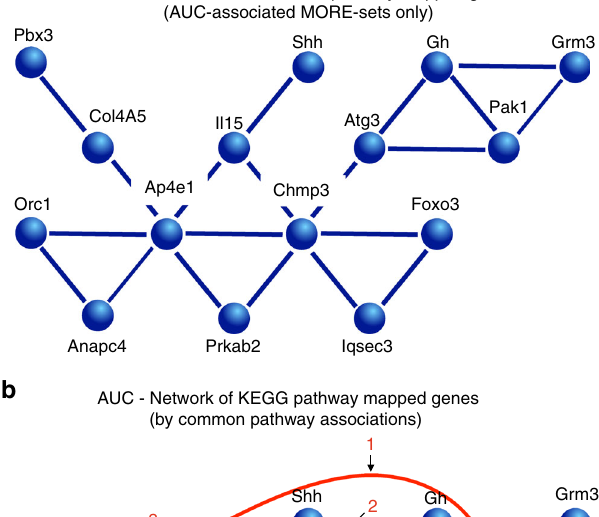
Fig. 6 The joint MORE set and KEGG pathway network. Fifteen genes from the gene list AUC female impaired (KEGG) for which MORE set connections were also found. Male impaired did not yield results. a AUC gene network derived from KEGG pathway-mapped genes showing AUC- associated MORE sets only. b AUC gene network of KEGG pathway- mapped strong knockout genes by common pathway associations. c AUC overlay of MORE network and KEGG pathway network. (Legend extension: 1 = Focal adhesion — Mus musculus (mouse), 2 = JAK-STAT signaling pathway — Mus musculus (mouse), 3 = Pathways in cancer — Mus musculus (mouse), 4 = Neuroactive ligand-receptor interaction — Mus musculus (mouse), 5 = Chemokine signaling pathway — Mus musculus (mouse), 6 = PI3K-AKT signaling pathway — Mus musculus (mouse), 7 = FoxO signaling pathway — Mus musculus (mouse), 8 = AMPK signaling pathway — Mus musculus (mouse), 9 = Longevity regulating pathway — Mus musculus (mouse), 10 = Endocytosis — Mus musculus (mouse), 11 = HTLV-I infection — Mus musculus (mouse), 12 = PI3K-AKT signaling pathway — Mus musculus (mouse), 13 = Cell cycle — Mus musculus (mouse), 14 = Basal cell carcinoma — Mus musculus